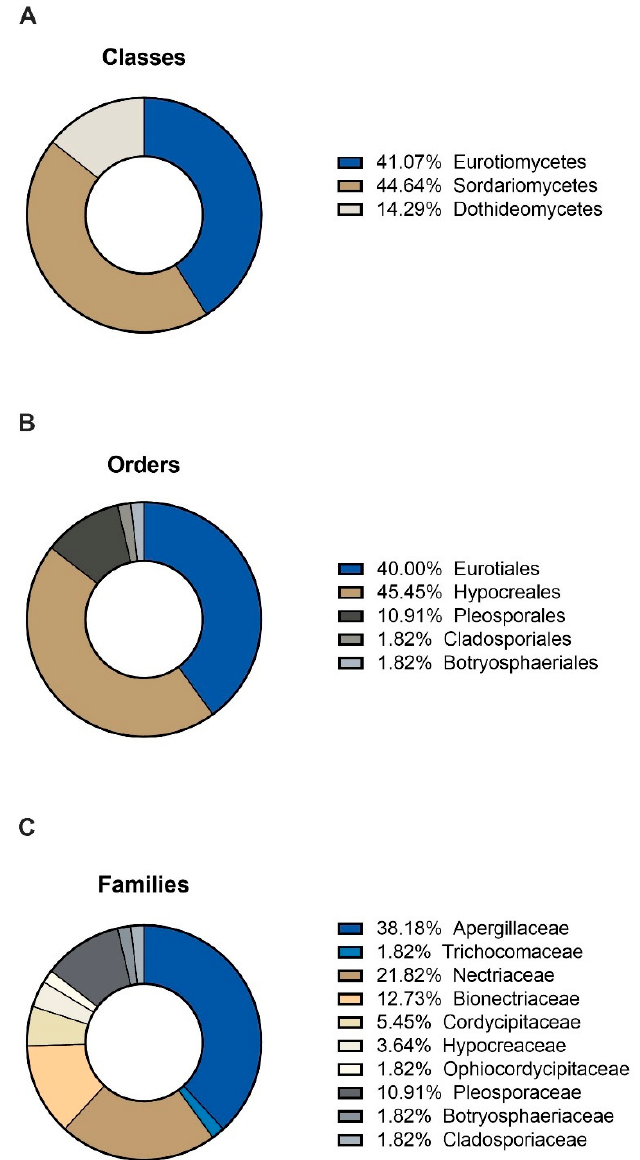
Figure 3. The relative abundance of fungal isolated according to ( A ) classes, ( B ) orders, and ( C ) families.